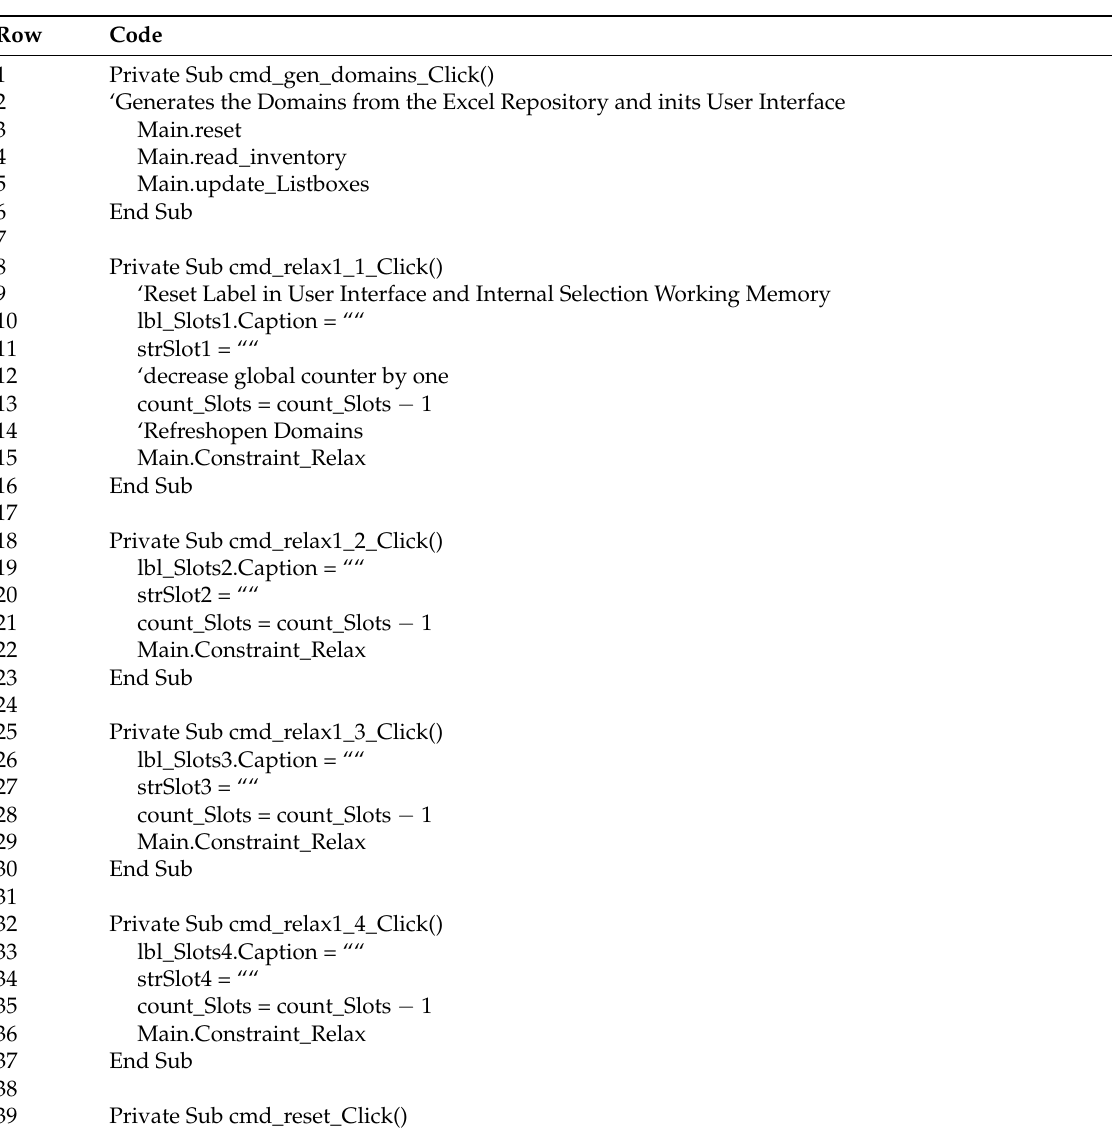
Table A2. VBA Code for Userform1